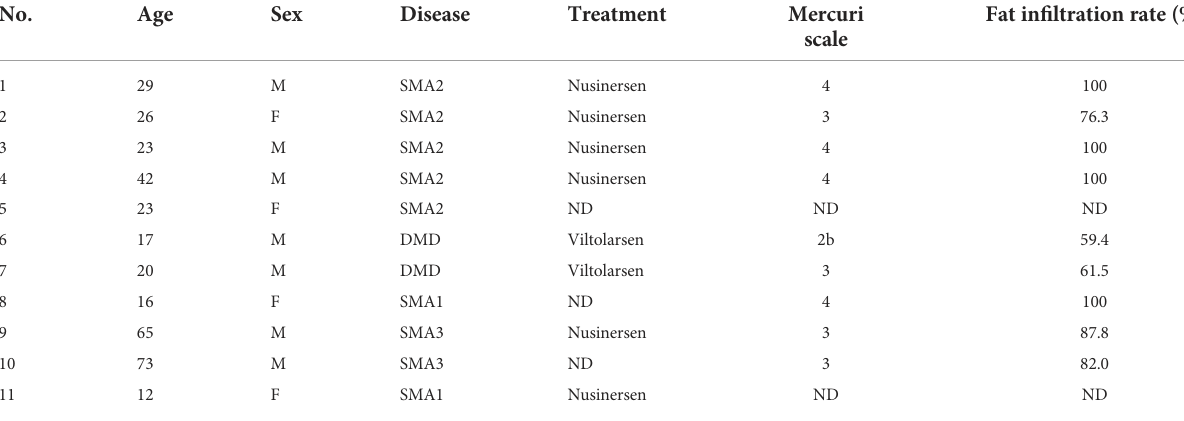
TABLE 2 Characteristics and residual muscle volume of NMD patients.